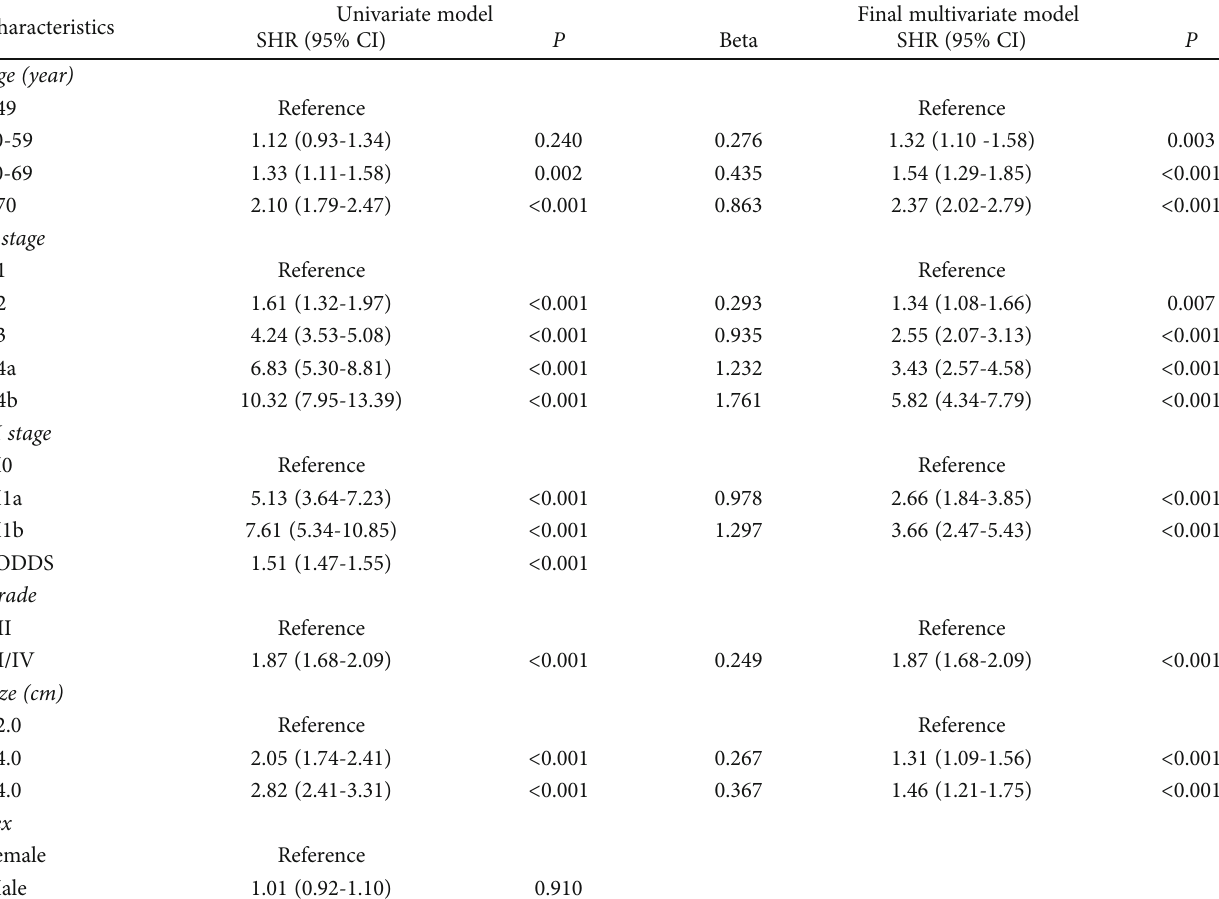
Table 2: Competing-risk survival analysis for exploring potential risk factors for prognosis of resected rectal cancer.